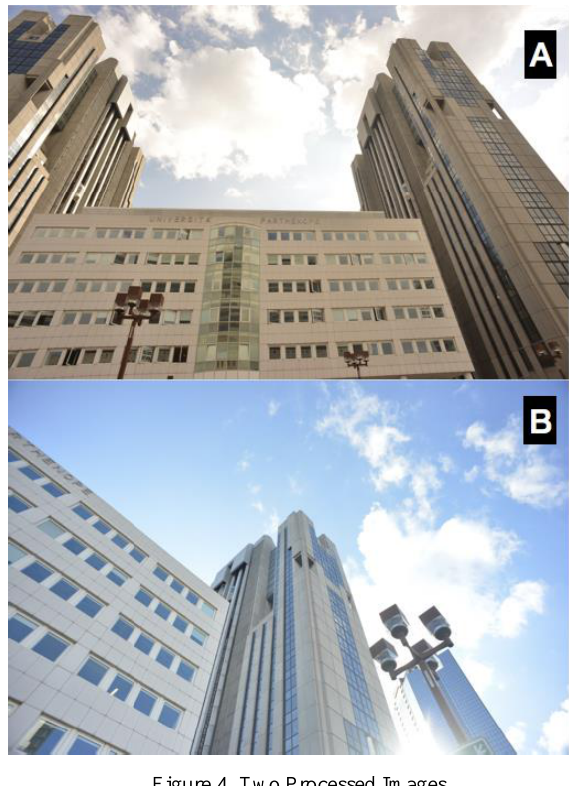
Figure 4. Two Processed Images